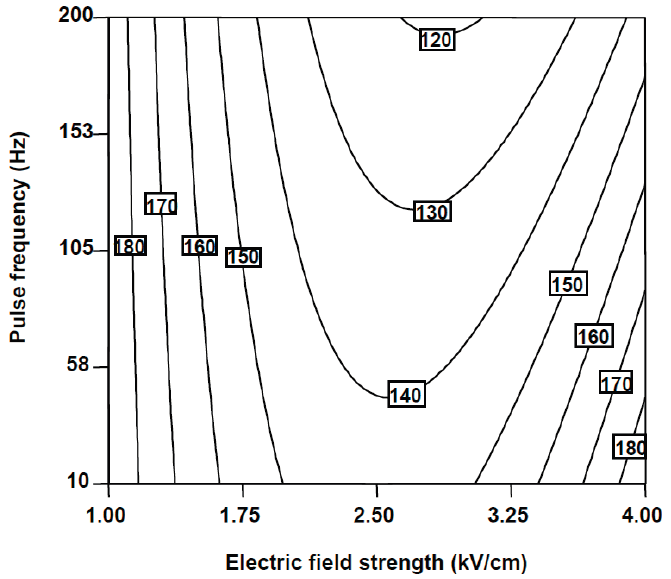
Figure 1. Counter plots for the combined effect of pulse frequency and electric field strength on FaOH relative content of carrot slices treated with 100 number of pulses at pulse widths of 10 μ